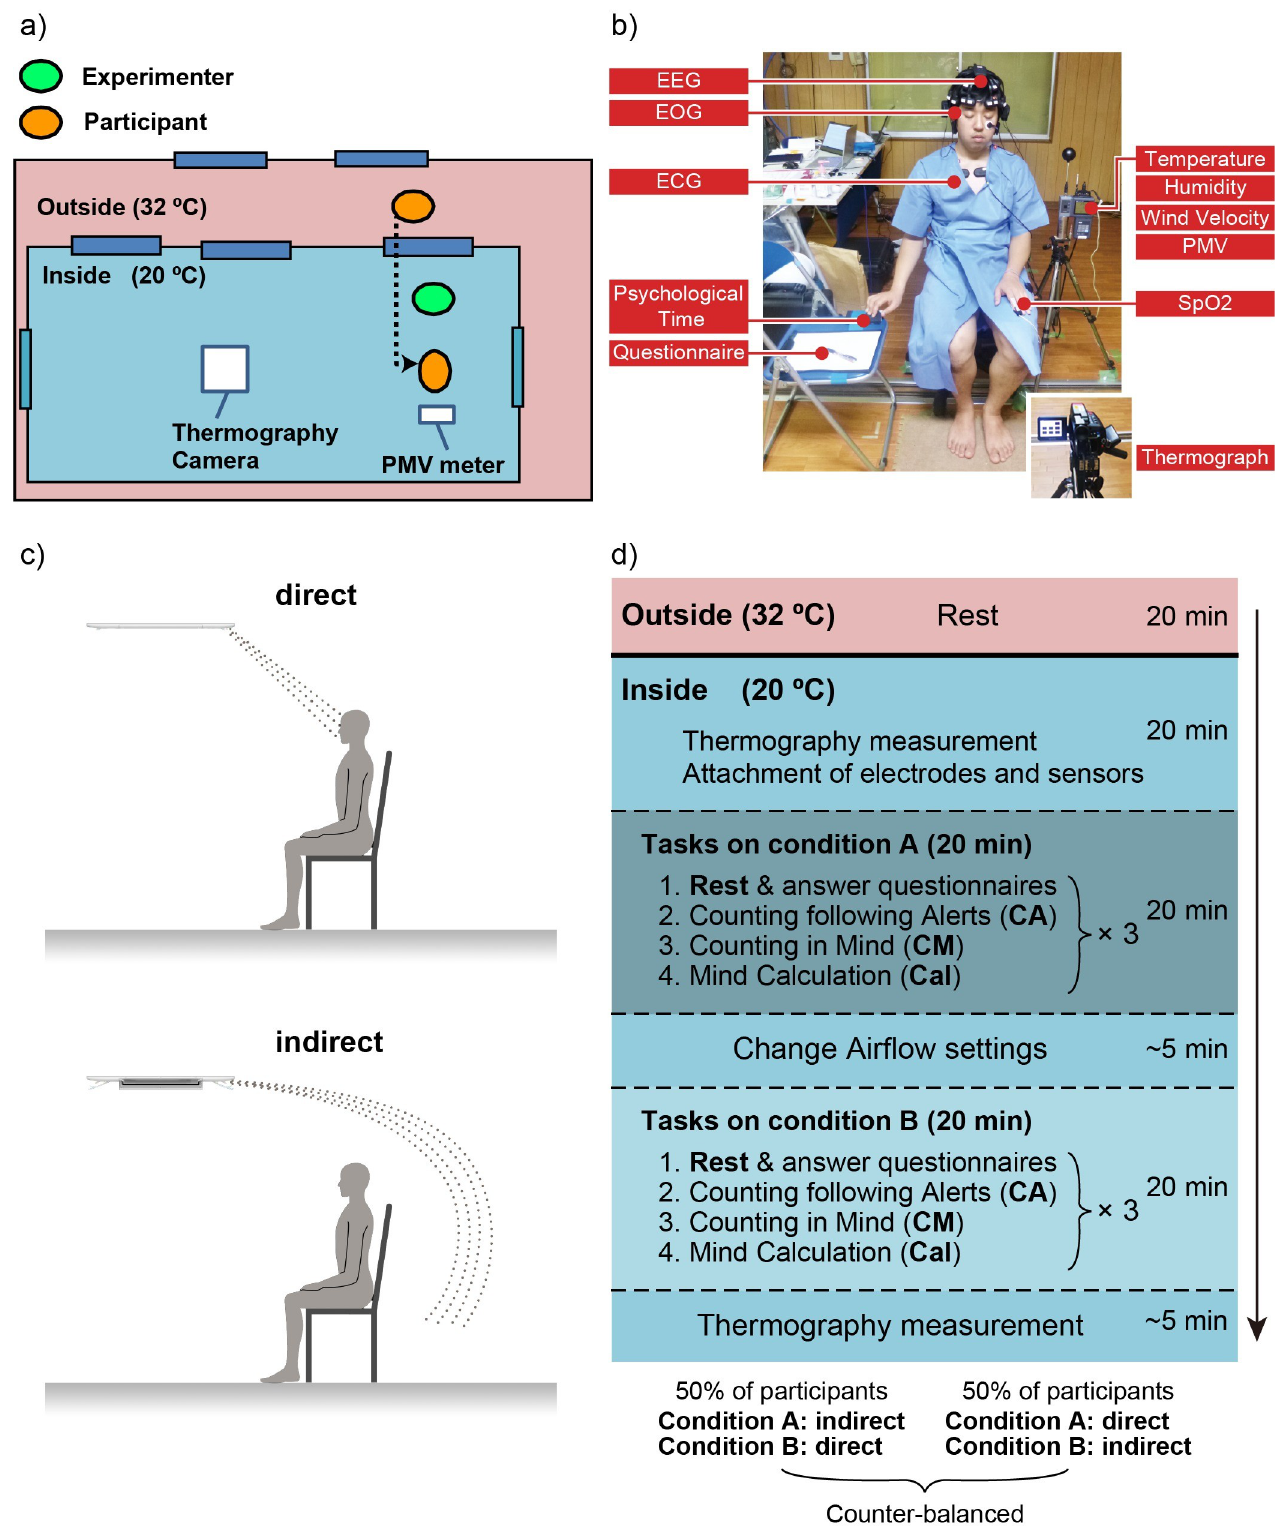
Fig 1. Experimental environment, settings, and procedure. a) Experimental environment. b) Sensor locations of the physical measurements and PMV meter. The thermography camera was located in front of the participants. c) Airflow directions of the two conditions, direct and indirect. d) Experimental procedure.